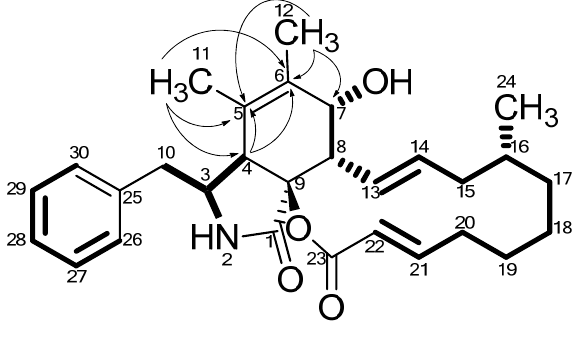
Table 3. Estimated LC